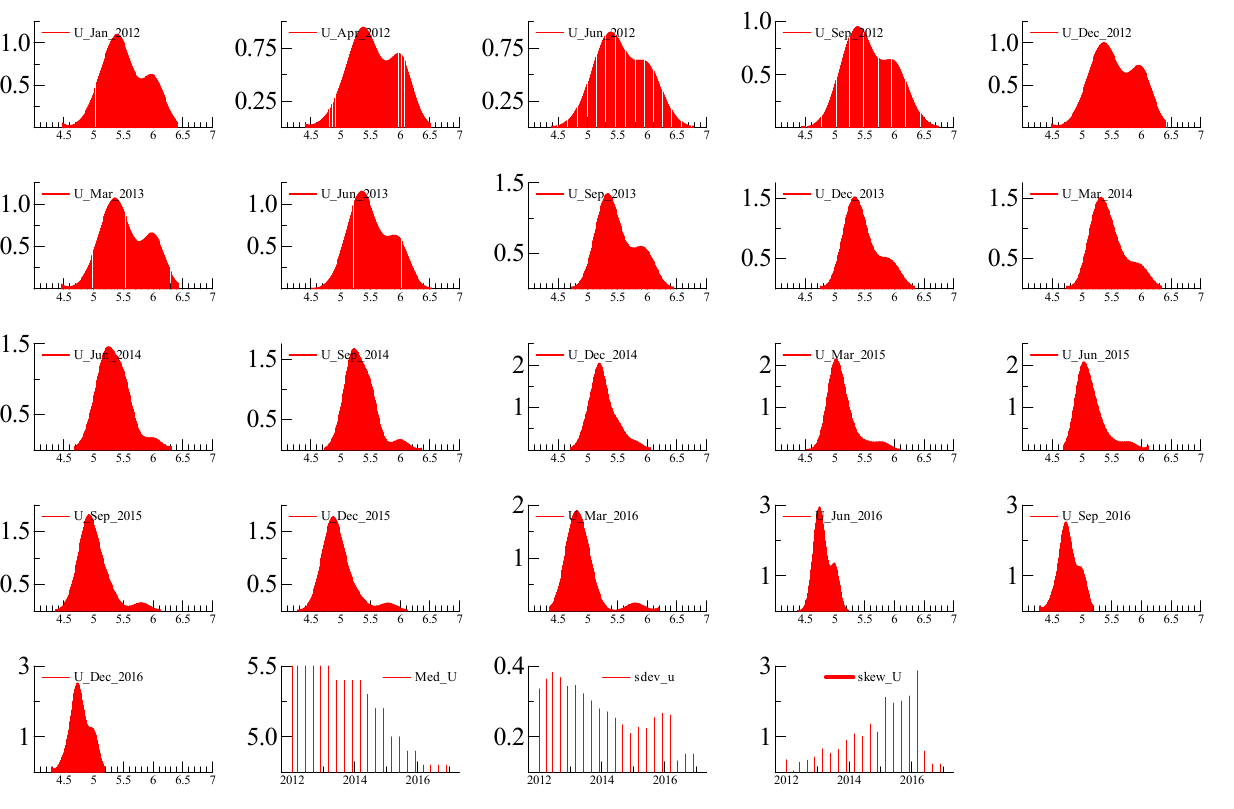
Figure 4. Marginal densities for the FOMC’s longer-run forecast of the Unemployment Rate—January 2012–December 2016. Panels with vertical lines correspond to three moments of the distributions: median, standard deviation, skewness.